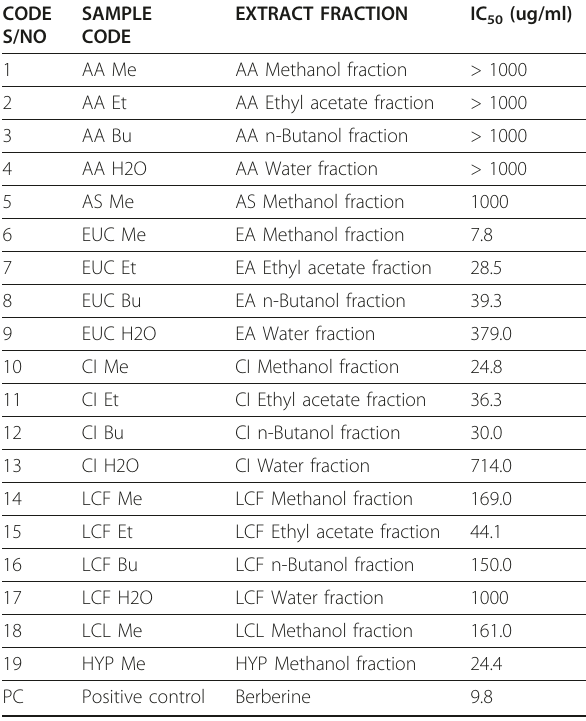
Table 2 Inhibitory concentration, IC 50 (ug/ml) of selected